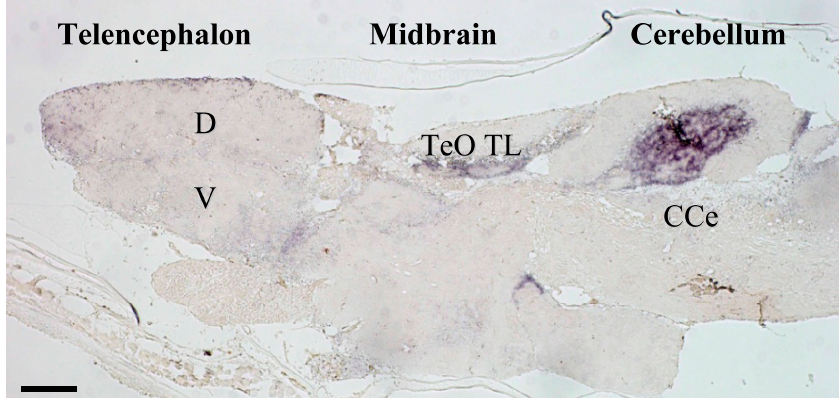
Figure 1. Photomicrograph of mineralocorticoid receptor (MR) in-situ hybridization in medaka brain. MR expression is restricted to a number of important areas that likely correspond to homologous brain regions containing MR in other vertebrates including those of humans [35]. Telencephalic regions exhibiting higher MR expression include the ventral parts of the lateral zone of the dorsal telencephalon (putative fish homologue of the mammalian hippocampus [36]), and commissural and subcommissural nuclei of the telencephalon (V; putative fish homologue to the mammalian amygdala) [36]. In the diencephalon, the hypothalamic preoptic area, inferior lobe of the hypothalamus, and glomerulus complex of the thalamus exhibit MR expression, as do the mesencephalic tegmentum and granular layer of the optic tectum. MR expressed markedly in some regions of the cerebellum. CCe, corpus cerebelli; D, dorsal telencephalic area; TeO, tectum opticum; TL, torus longitudinalis; V, ventral telencephalic area. The detailed expression profiles are described in Sakamoto et al. [13]. Ubiquitously expressed GR in the brains of rodent and fish, as well as MR expression in the rodent brain, have been illustrated elsewhere [15,37,38]. Scale bar: 100 µ